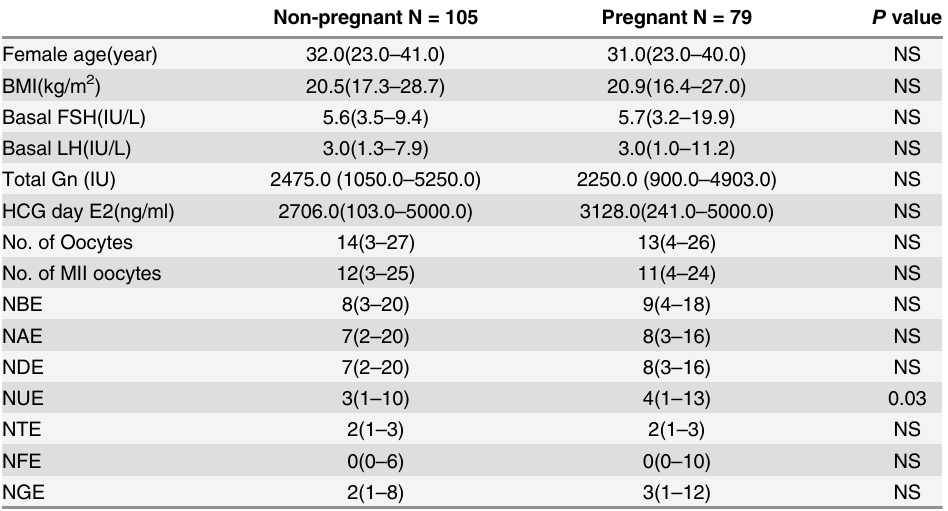
Table 7. Comparison between pregnant and non-pregnant group of PGD cycles of monogenic diseases.